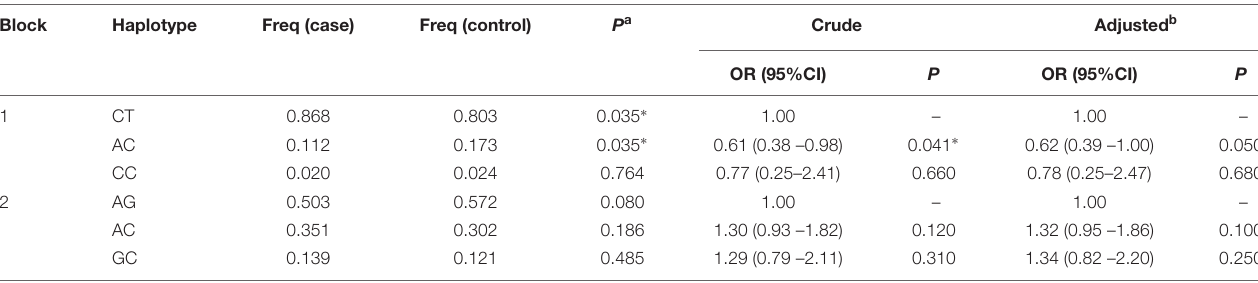
TABLE 5 | PPARA haplotype frequencies and the association with risk of HA appetite loss. Block